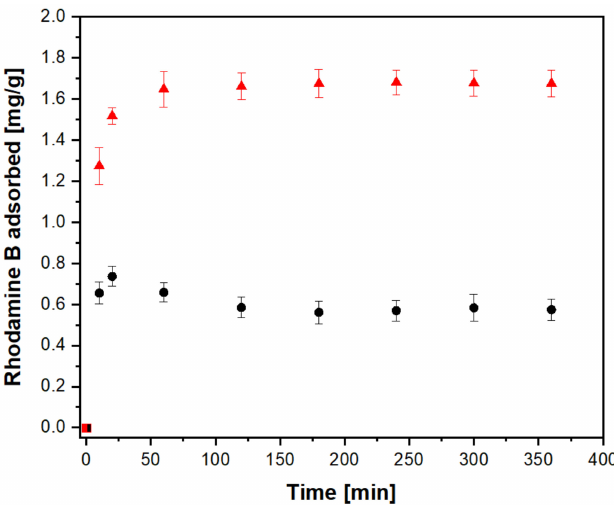
Figure 6. Amount of Rhodamine B adsorbed vs. time in water suspensions of kaolinite (black circles) and silica particles (red triangles). Initial amount (squares) is 0. Error bars represent the standard deviation over three